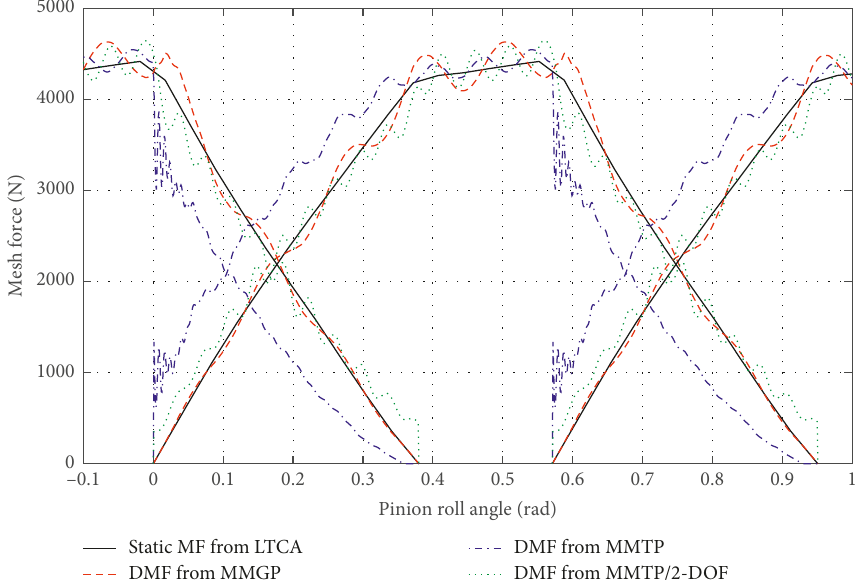
Figure 17: Time histories of DMF per tooth pair at 50Hz mesh frequency and 300Nm torque